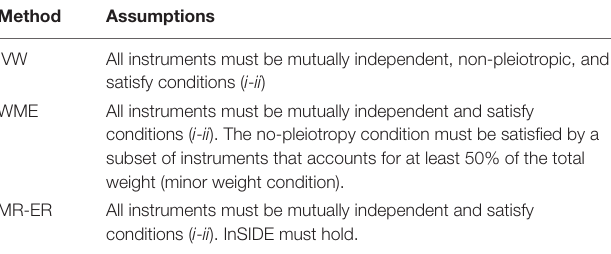
TABLE 1 | Assumptions required by employed methods.